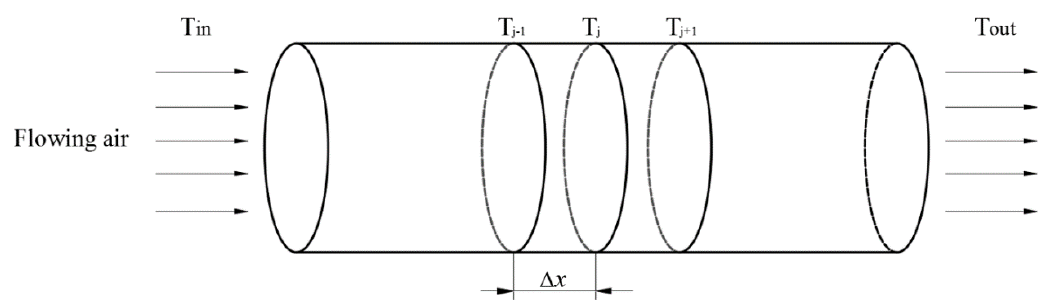
Figure 2. The divided volume elements of the underground air tunnel system.